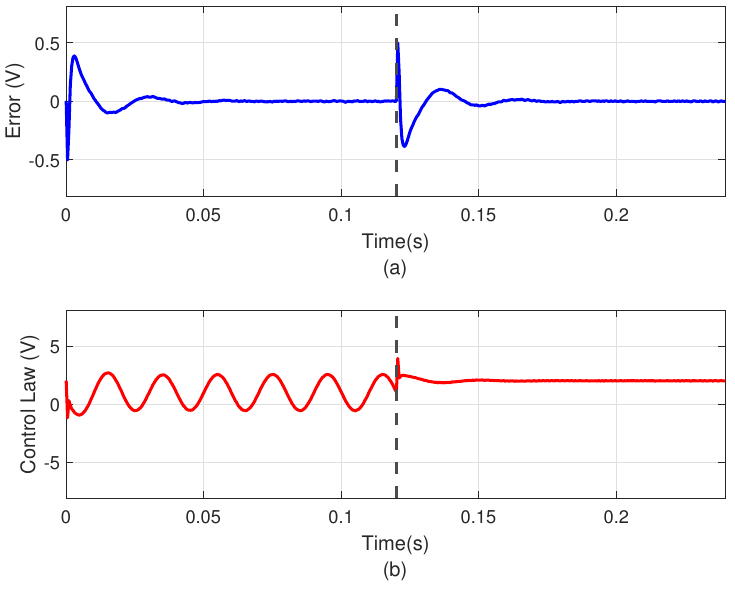
Figure 9. Experimental result for test 2, using p = 20, c = 1, r u = 0.07. ( a ) Error. ( b ) Control